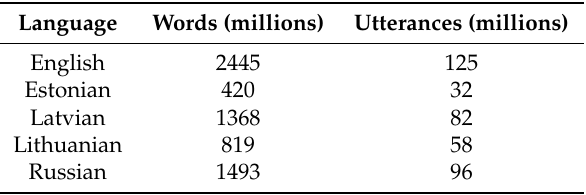
Table 3. Sizes of the corpora used for training the word embeddings.